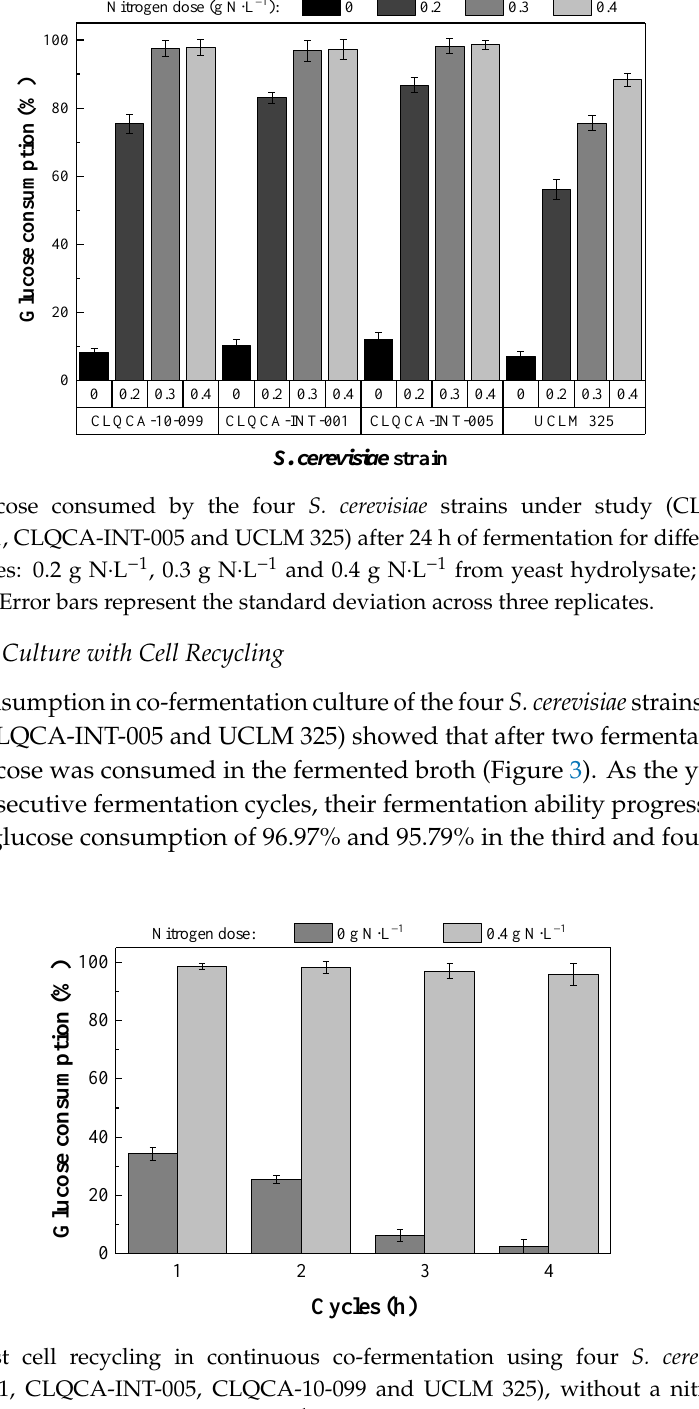
Figure 3. Yeast cell recycling in continuous co-fermentation using four S. cerevisiae strains (CLQCA- INT-001, CLQCA-INT-005, CLQCA-10-099 and UCLM 325), without a nitrogen source and with